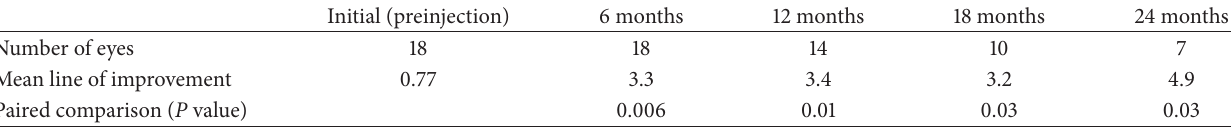
Table 2: Mean lines of visual acuity improvement after anti-VEGF injections (excluding 6 PDT & 2 chronic CNV eyes) ∗ .